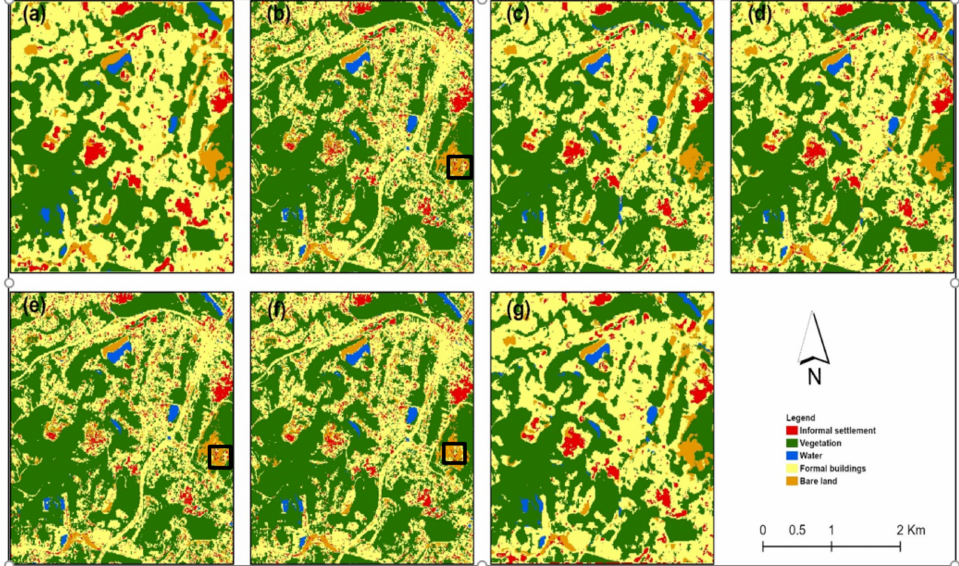
Figure 4. LULC maps obtained using different feature combinations from ( a ) Txts, ( b ) SIs, ( c ) SIs + Txts, ( d ) SBs + SIs + Txts ( e ) SBs + SIs, ( f ) SBs, ( g ) SBs +